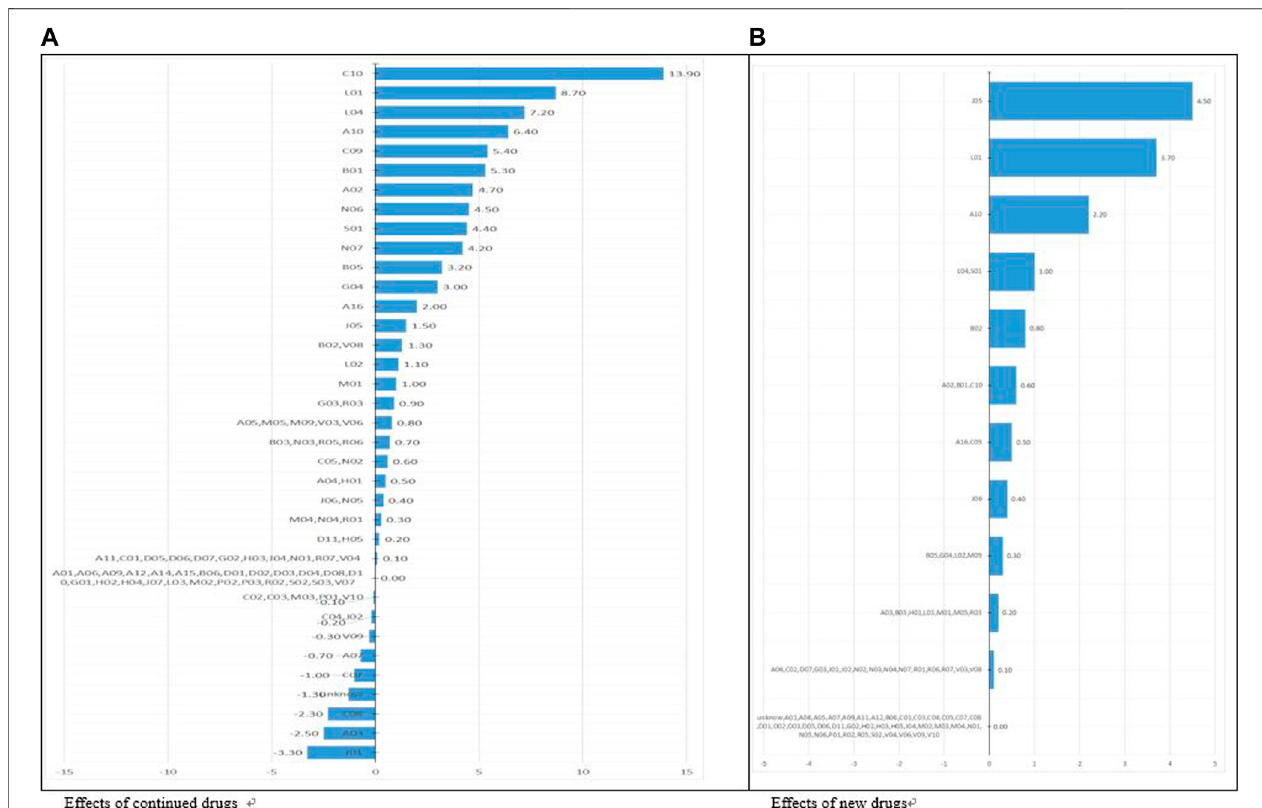
FIGURE 2 | Effects of drugs by categories (continued, new) categorized by ATC level 2 (%).